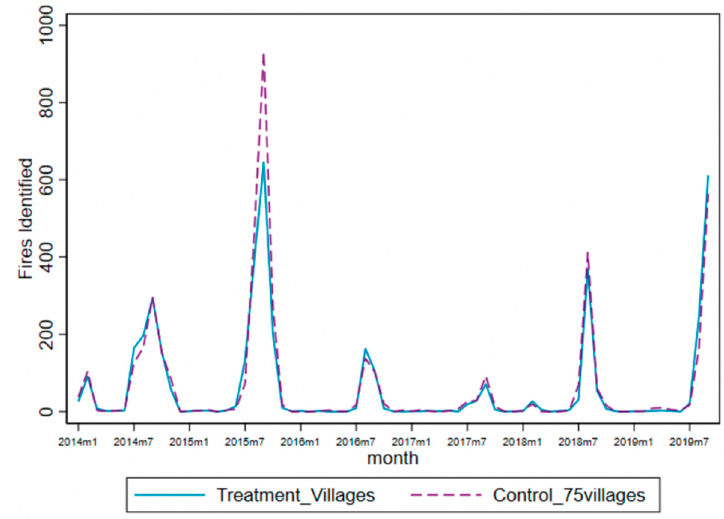
Figure 3. Fires in Experimental and Control Villages, 2014–2019.